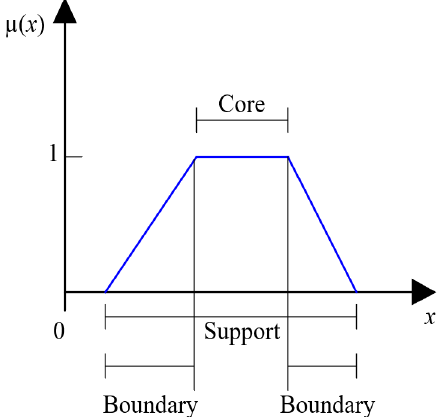
Figure 1. Components of a membership function.